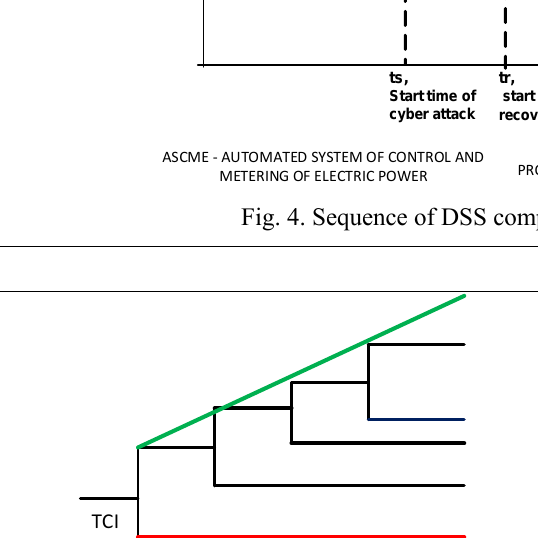
Fig. 5. Two enveloping curves of the Event Tree for TCI